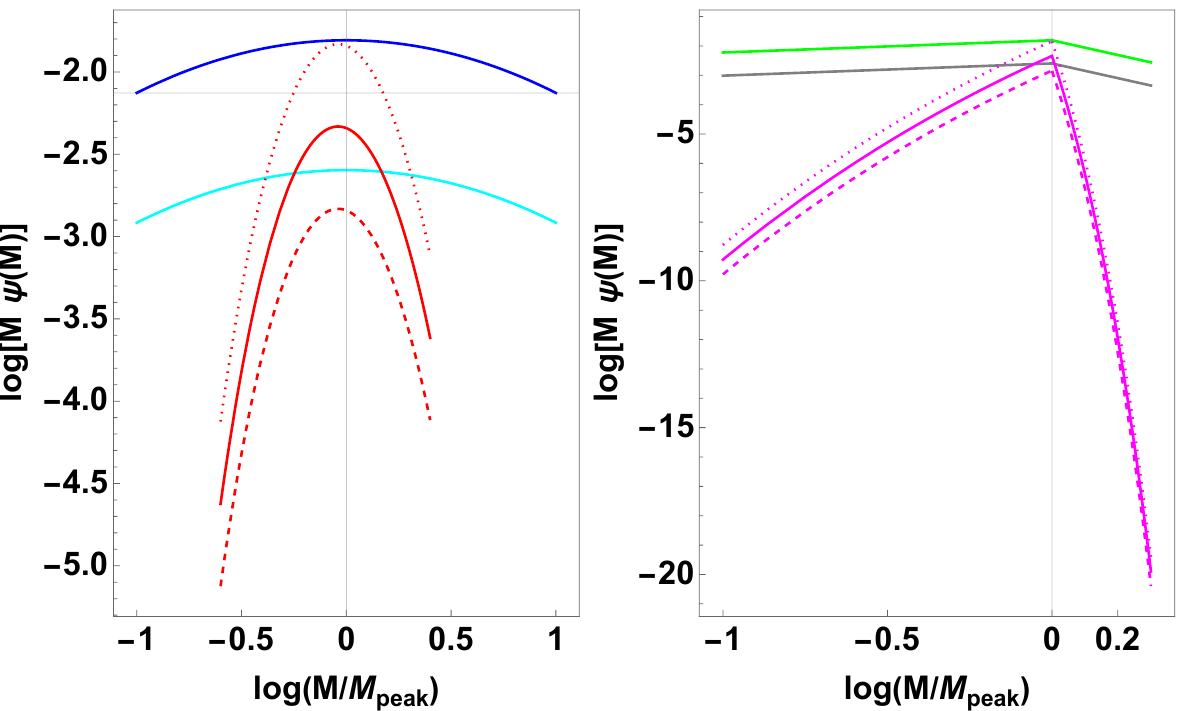
10 − 3 for w = 0 × , respectively. (cid:12)